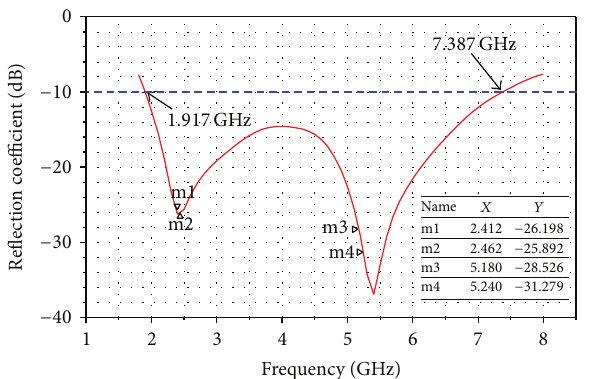
Figure 3: The broadband printed antenna reflection